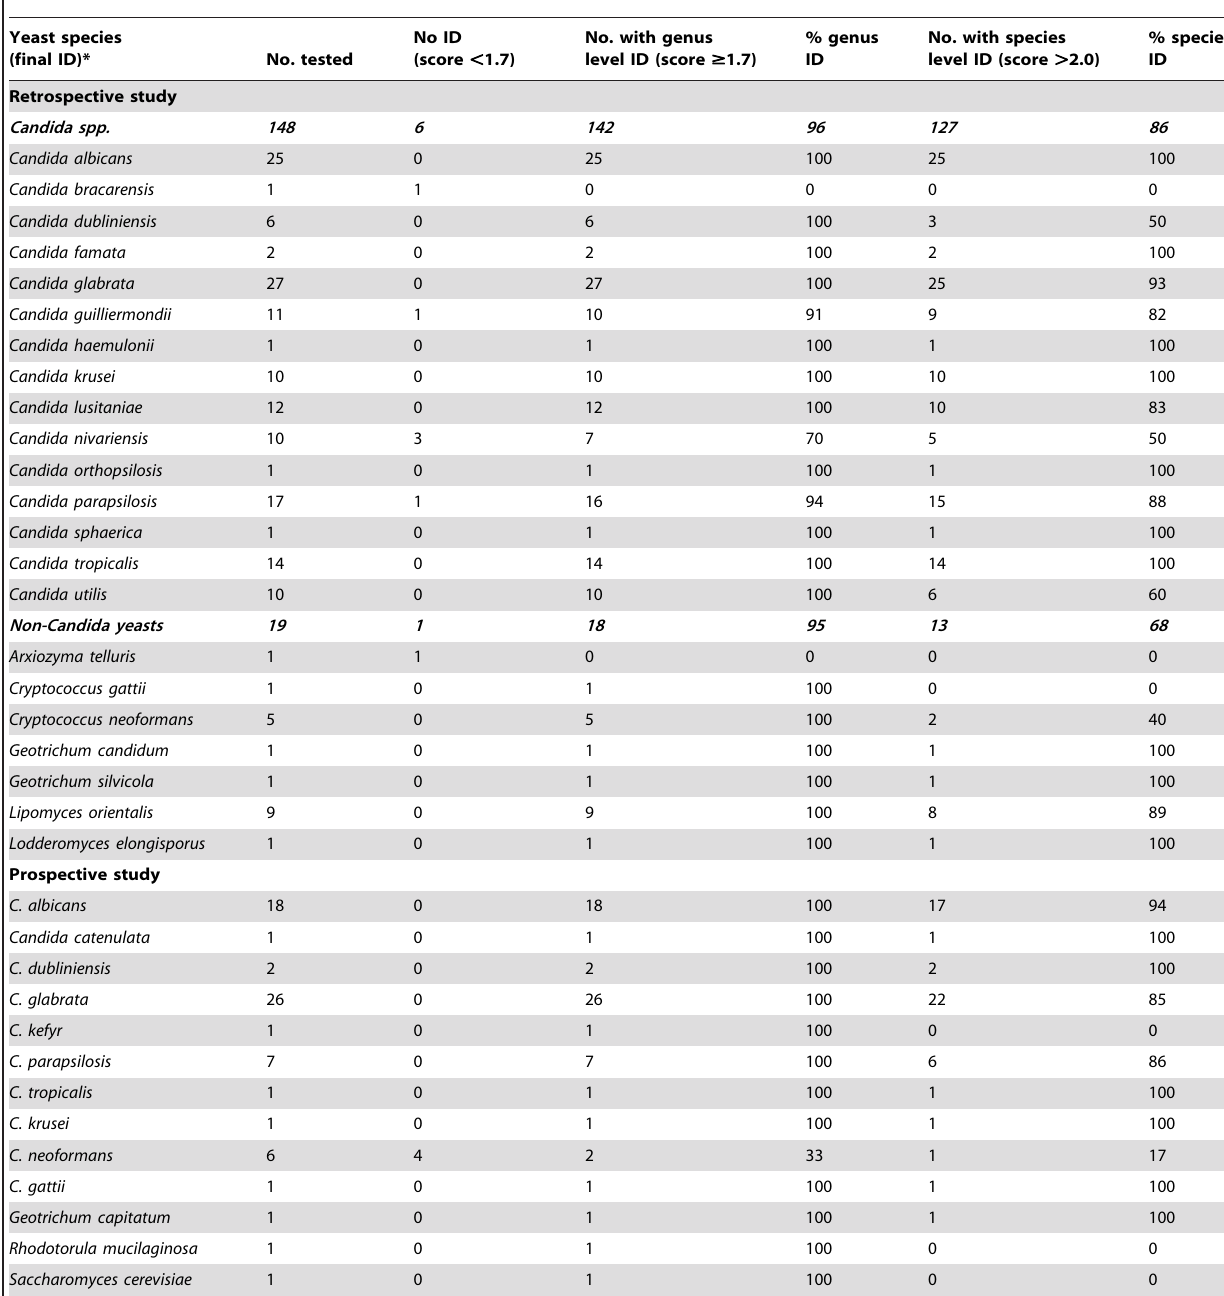
Table 2. Species and genus identification of clinical yeast isolates by MALDI-TOF MS.